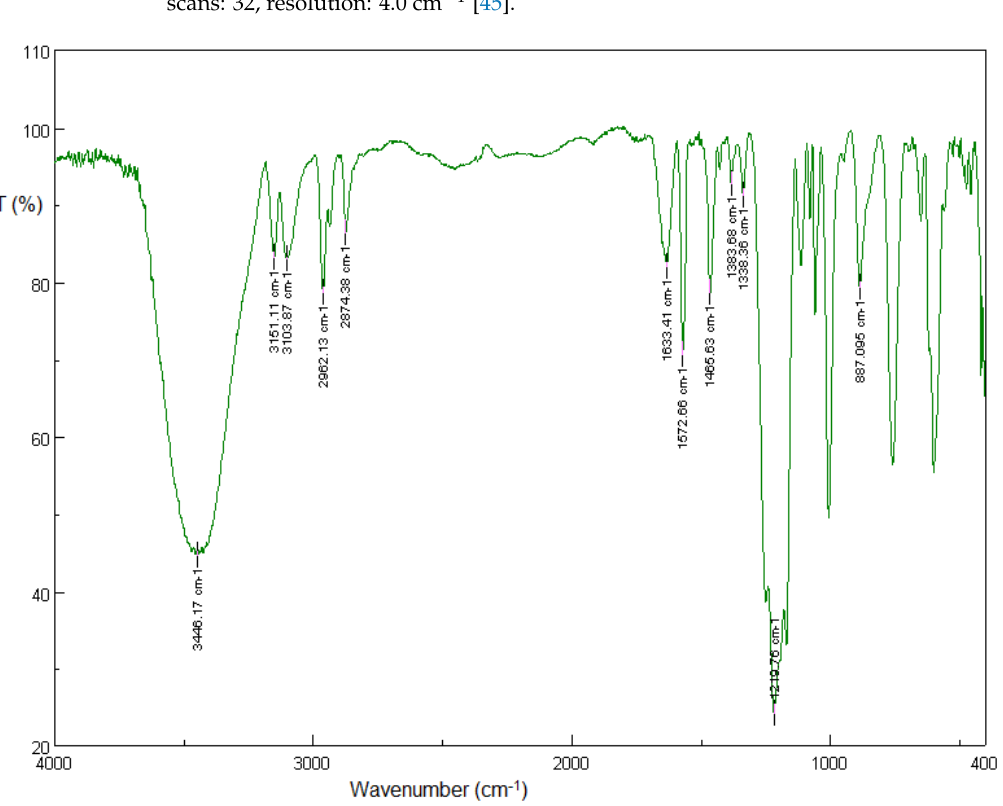
Figure 2. Solid-state FT-IR spectrum of the fresh [BMIM][Br]. Sample pellet with KBr, number of scans: 32, resolution: 4.0 cm − 1 [45].